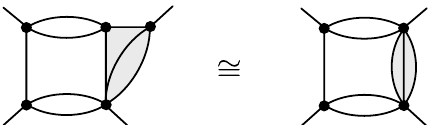
Figure 15: An example of a sub-triangle (left) that is equivalent to a 3-particle bubble (right). The top right vertex of the triangle obeys condition (36) with a ( − ) sign while the top left vertex obeys this condition with a (+) sign. Therefore, in order for an α -positive solution to be possible, the momenta p entering the bottom vertex must satisfy (36) with a (+) sign, i.e. p 2 = ( m + 2 m ) 2 = 9 m 2 , which makes the triangle equivalent to the bubble with three legs on the right.